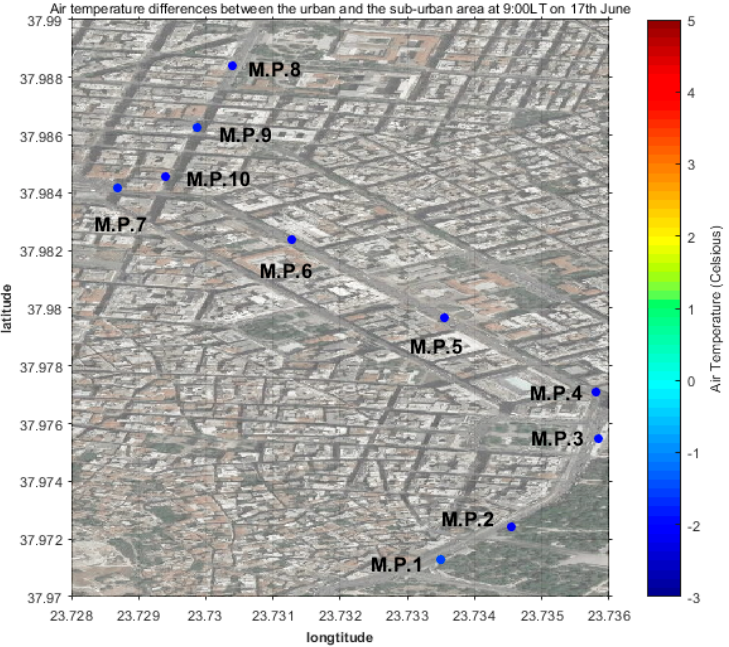
Figure 5. Air temperature differences between the ones recorded in the center of Athens at 9:00LT and the ones in the suburban station, during the 17th June.